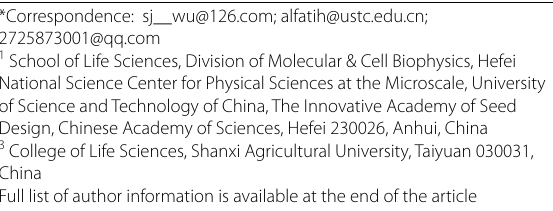
label on the bottom of the right image of Fig. 1A “KNO 3 / correct figure is given